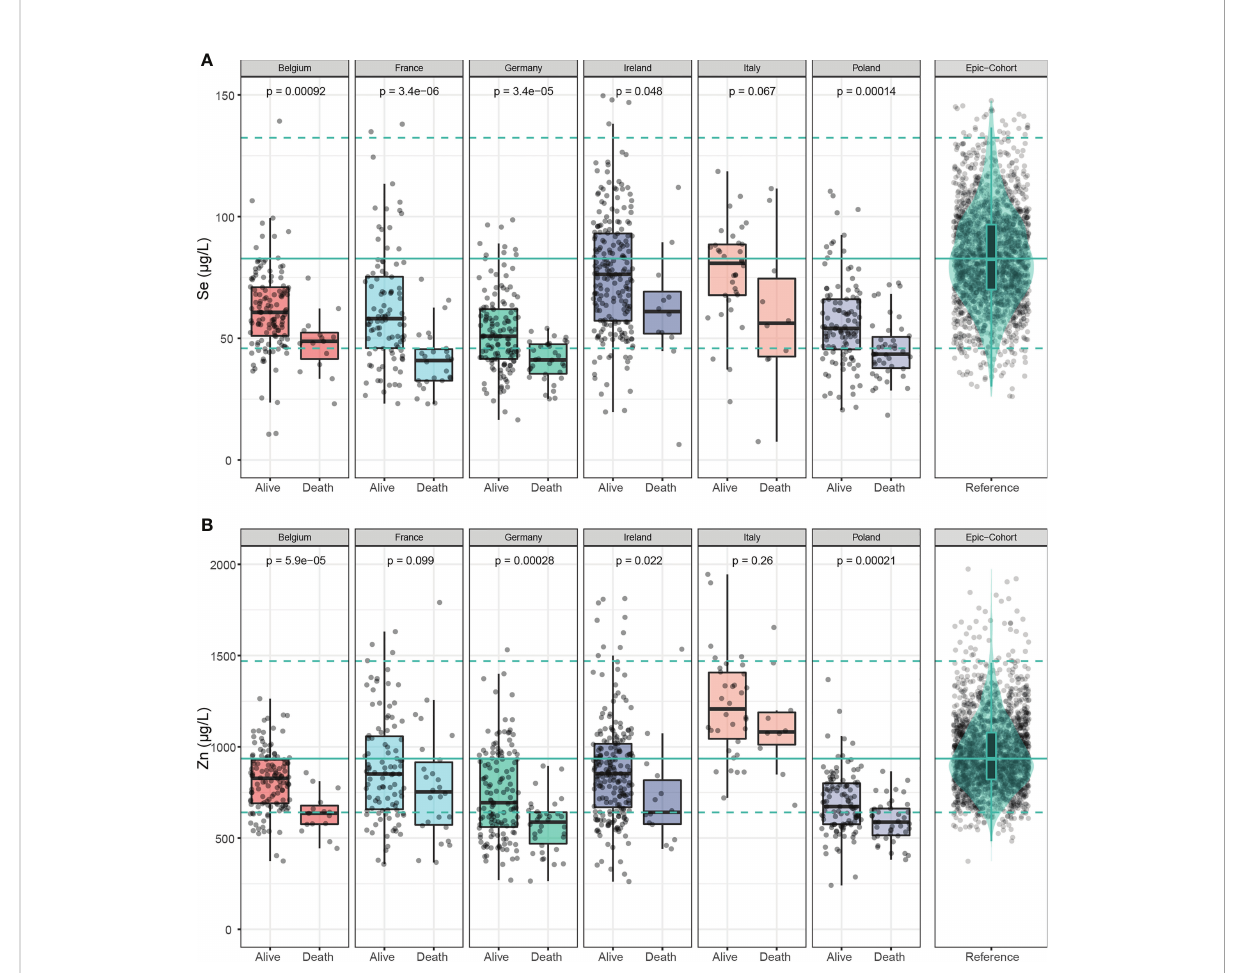
FIGURE 3 Selenium and Zn status in samples of deceased and alive patients. (A) Serum Se concentrations were lower in samples of non-survivors than in survivors across all countries. (B) Serum Zn concentrations were also relatively low in the non-survivors across all countries. The green line denotes the median value as determined in EPIC, and broken lines indicate the 2.5th and 97.5th centiles. Results from Wilcoxon-Rank-sum testing are indicated as